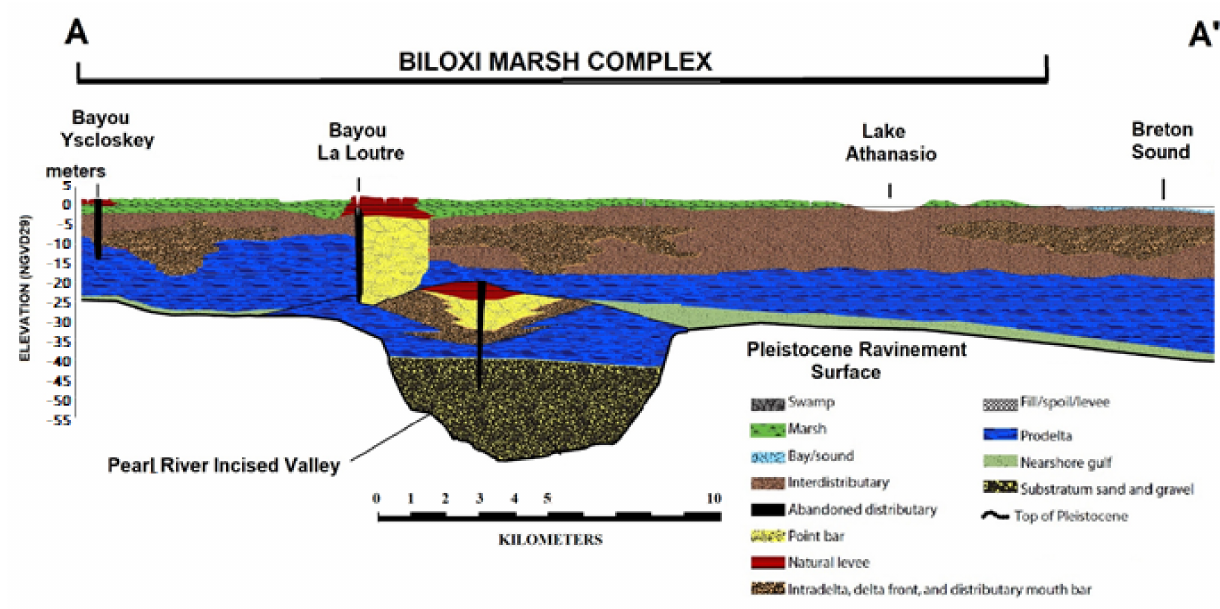
Figure 4. Biloxi Marsh portion of cross-section drawn by Fitzgerald et al. [32] from USACE boring logs made along the MRGO right of way prior to dredging [42]. Section A—A’ location is shown on Figure